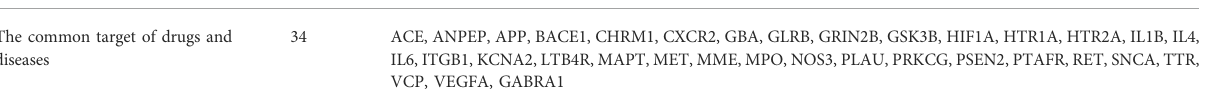
TABLE 2 The common target of drugs and diseases.